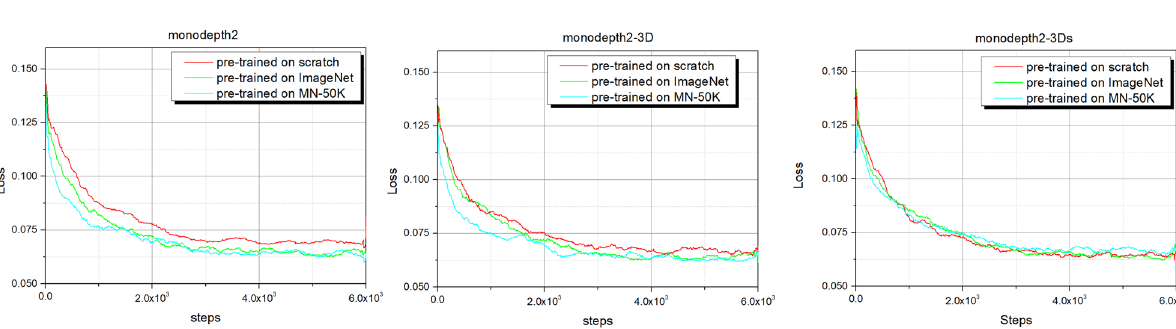
Figure 8. Fine-tuning curves of three test models on KITTI. Solid curves denote accuracy ( δ depth estimation and dash curves denote training loss.